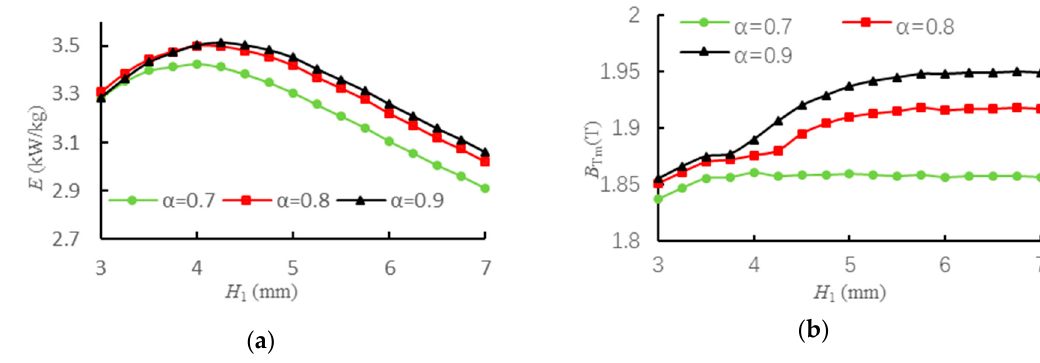
Figure 3. ( a ) Changes of the power density with the thickness of the stator yoke; ( b ) Changes of the magnetic density at the motor teeth with the thickness of the stator yoke.